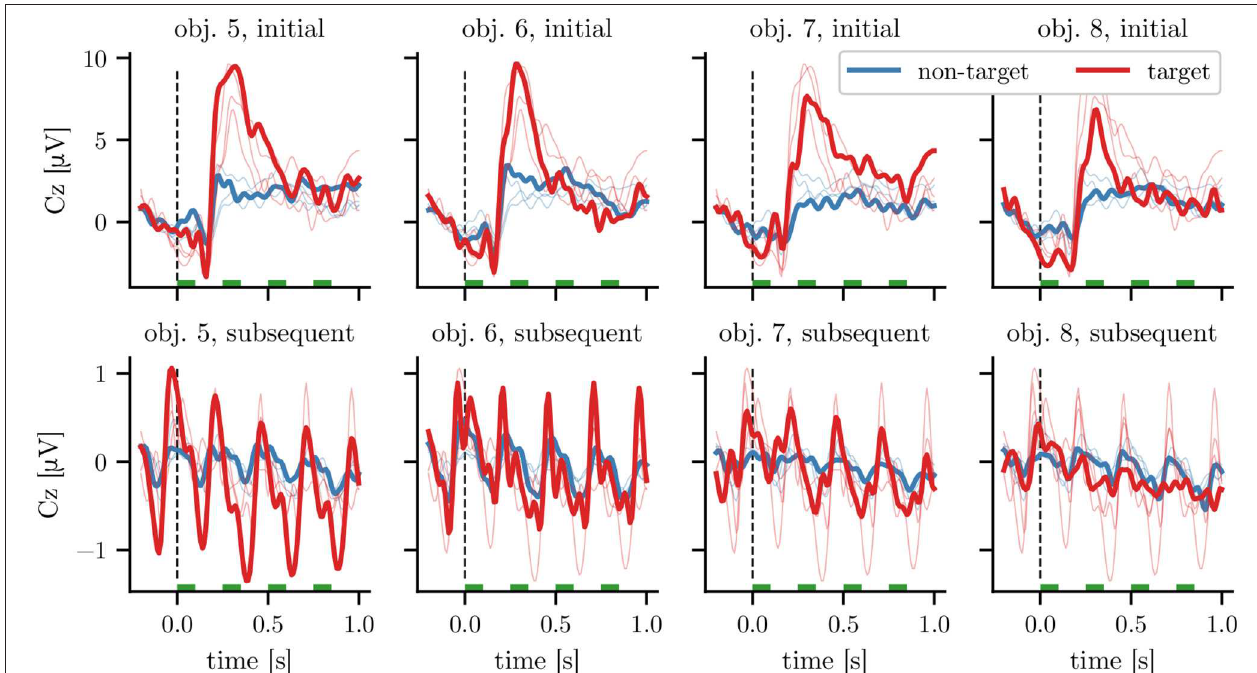
FIGURE 5 | Grand average responses at electrode Cz for heterogeneous objects. Each column corresponds to the responses to the highlighting of a single object. The top row depicts the response to the initial stimulus of a 3s stimulation sequence, while the bottom row depicts the average response to the 11 subsequent ones (see Figure 1 for averages over the full stimulation sequence). Time 0 corresponds to the onset of highlighting, with all stimulation intervals marked with green bars. For ease of comparison, the averages for other objects of the same row are shown with thin lines. The averages are calculated on the combined data of the 13 participants of datasets HET1 and HET2 using an SOA of 250ms. The target (non-target) averages are calculated based on 234 (702) and 2,574 (7,722) time windows for the plots in the top and bottom row, respectively (before artifact